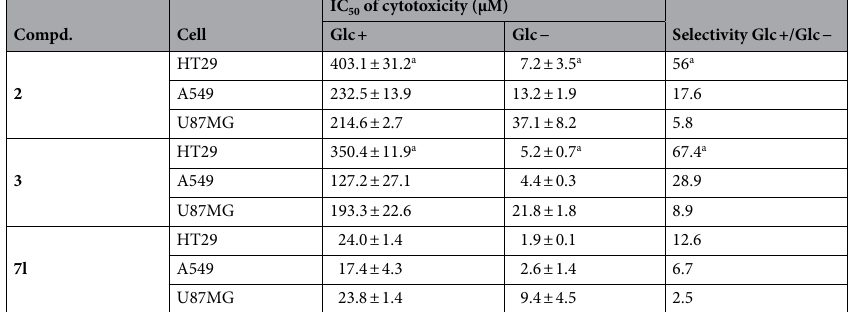
IC 50 of cytotoxicity